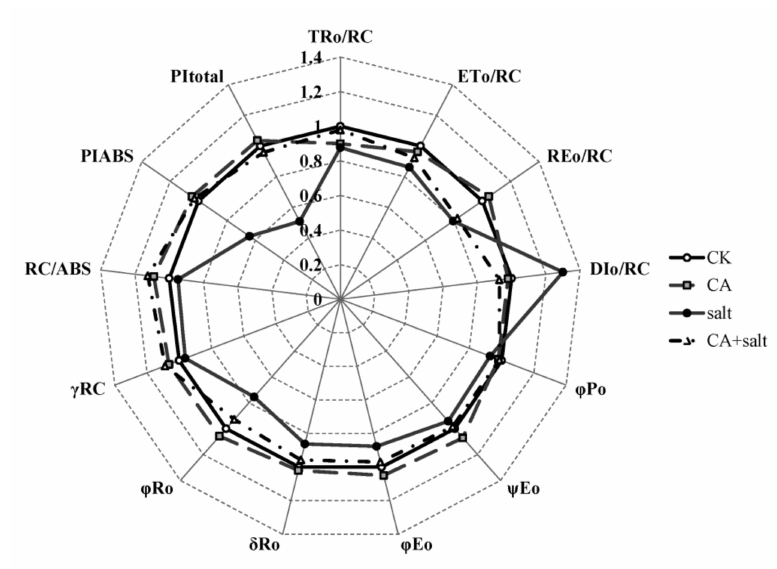
Figure 5. Parameters of JIP test analysis in bermudagrass under di ff erent treatments. Mean values were calculated from three independent experiments. CK = control; NA = non-cold treatment; CA = pre-cold treatment for 6